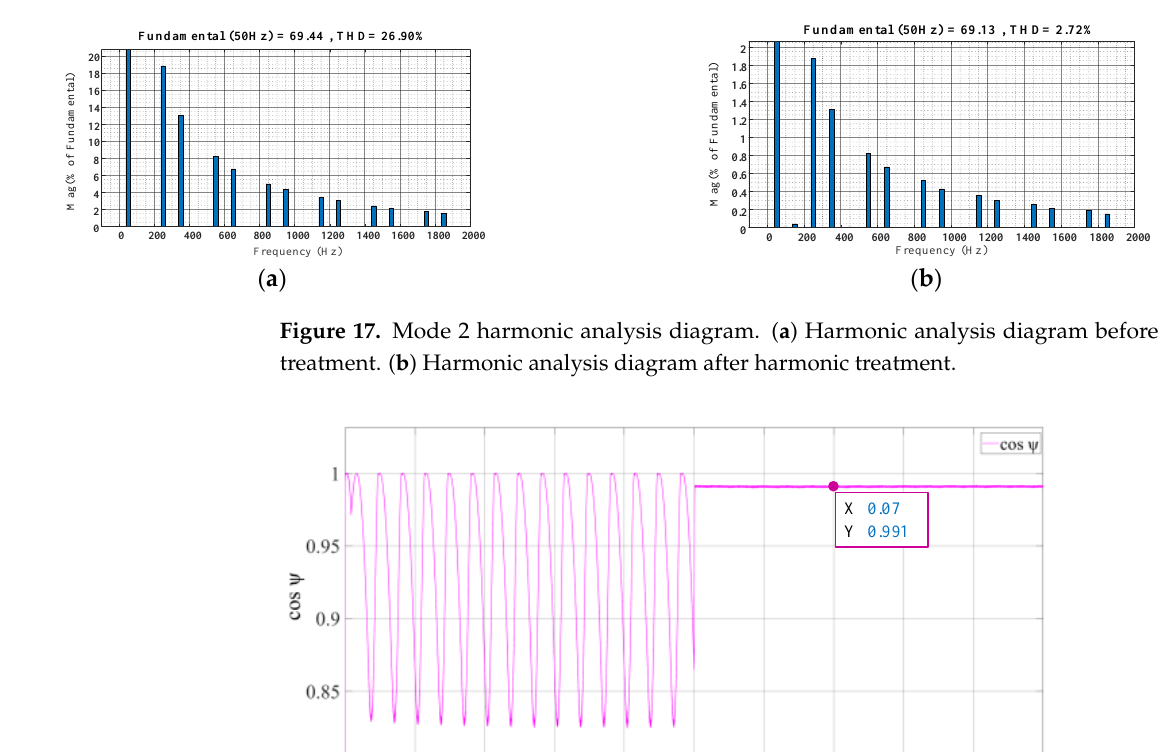
Figure 18. Mode 2 grid-connected power factor.